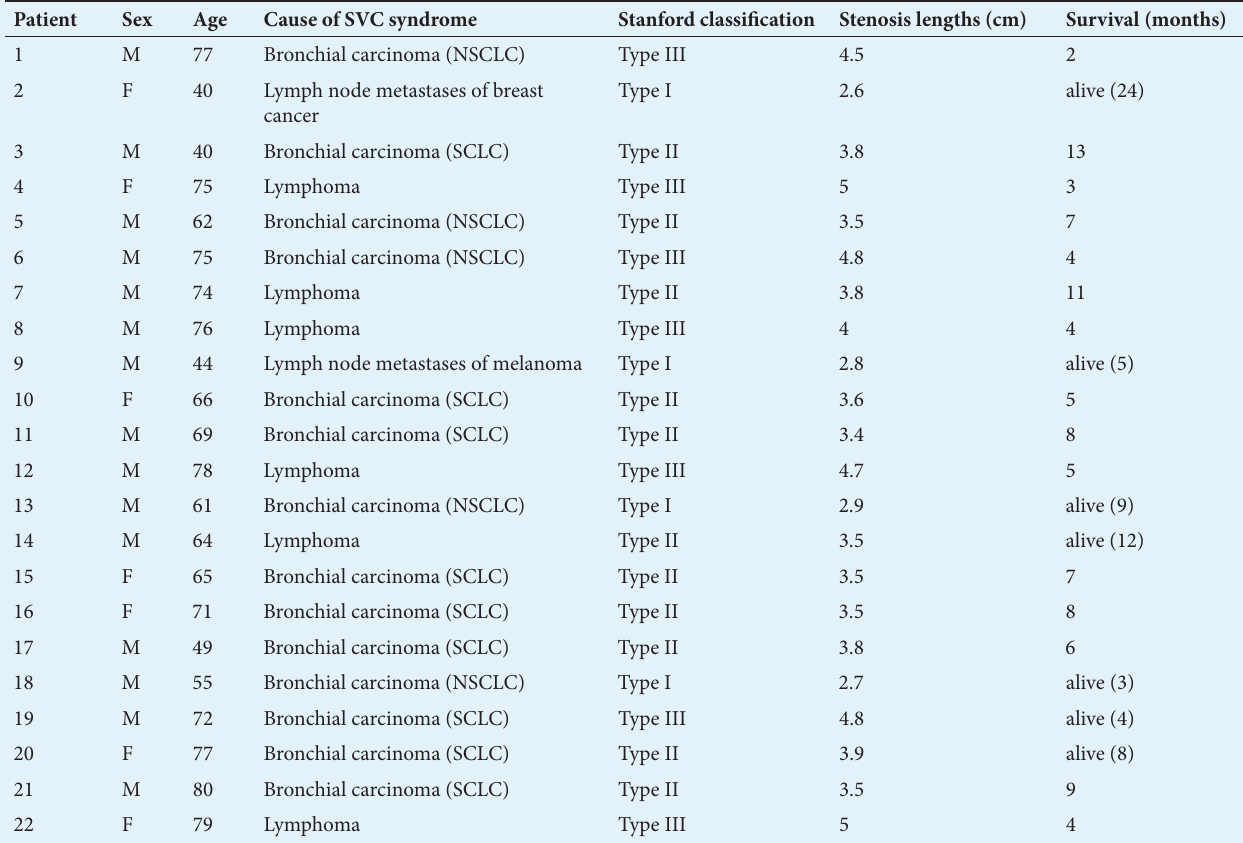
Table 1. Patient